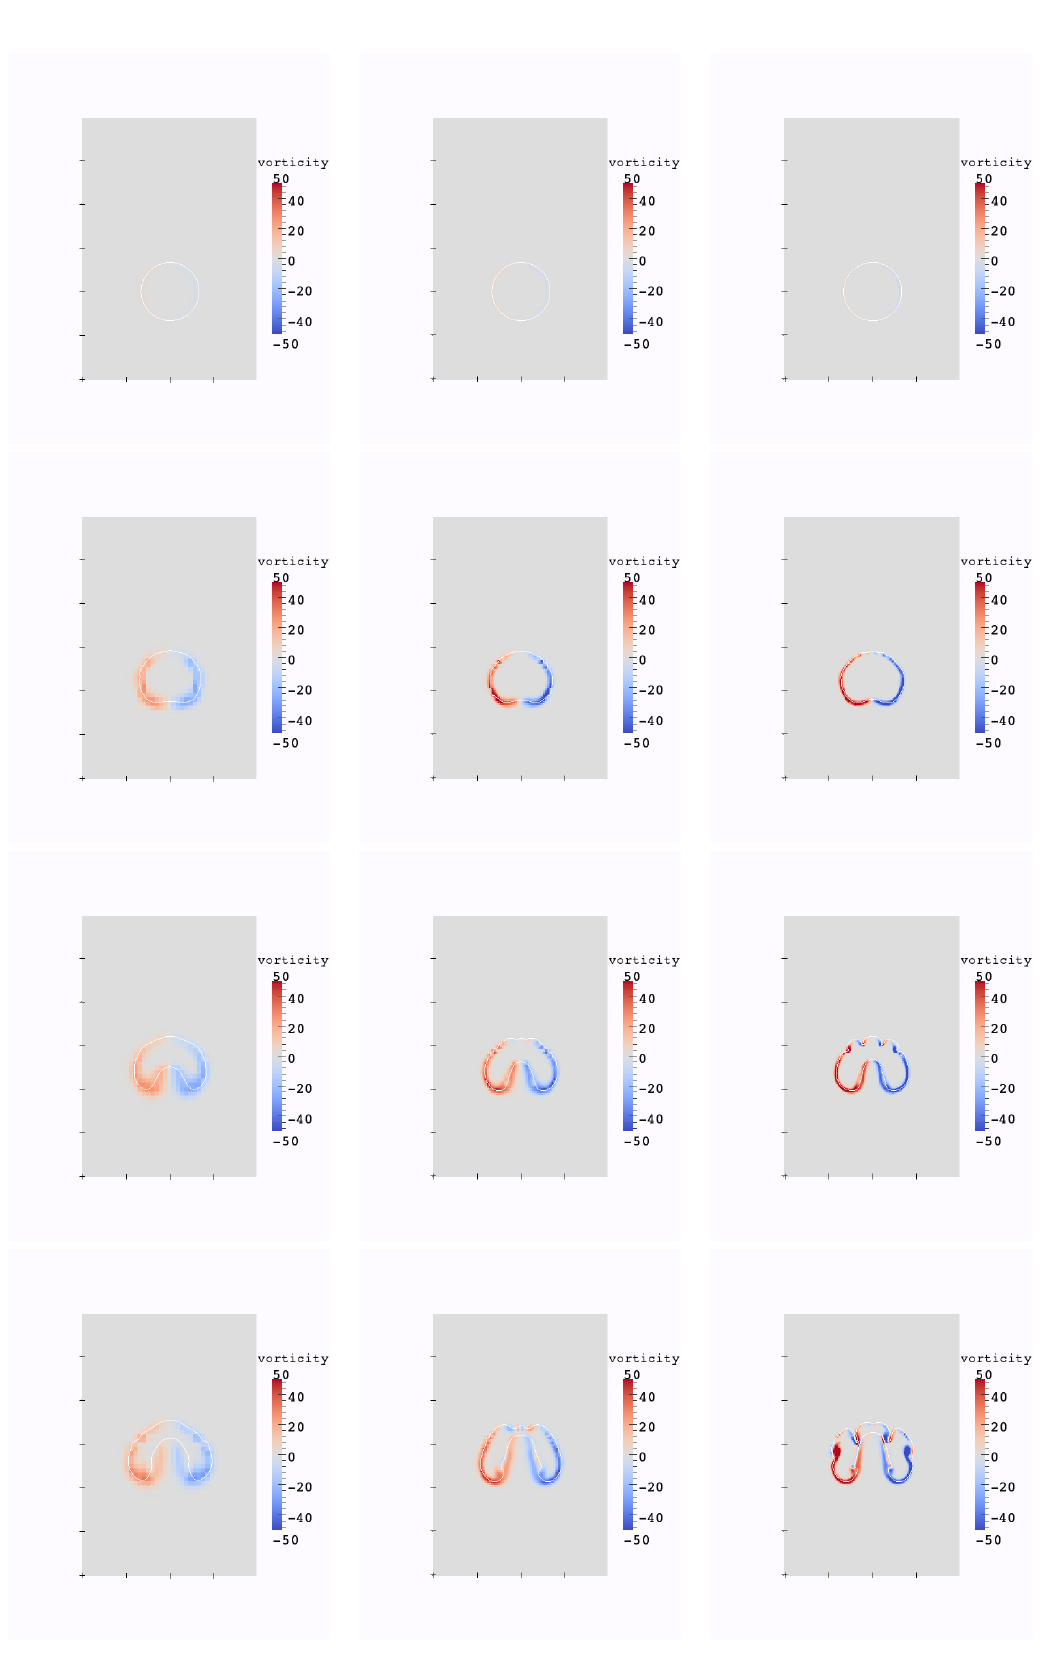
Figure 10. Evolution of the interface and vorticity values for the large bubble test case, at times 0, 0.2, 0.35, 0.5, resolution: 40 × 60 ( left ); 80 × 120 ( middle ); 160 × 240 ( right